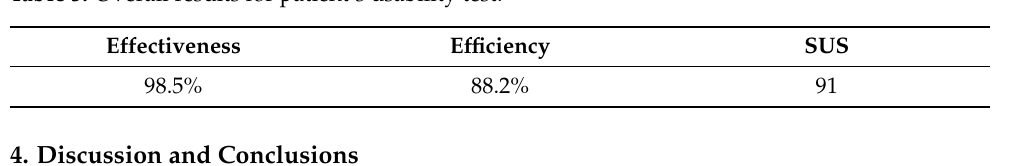
Table 3. Overall results for patient’s usability